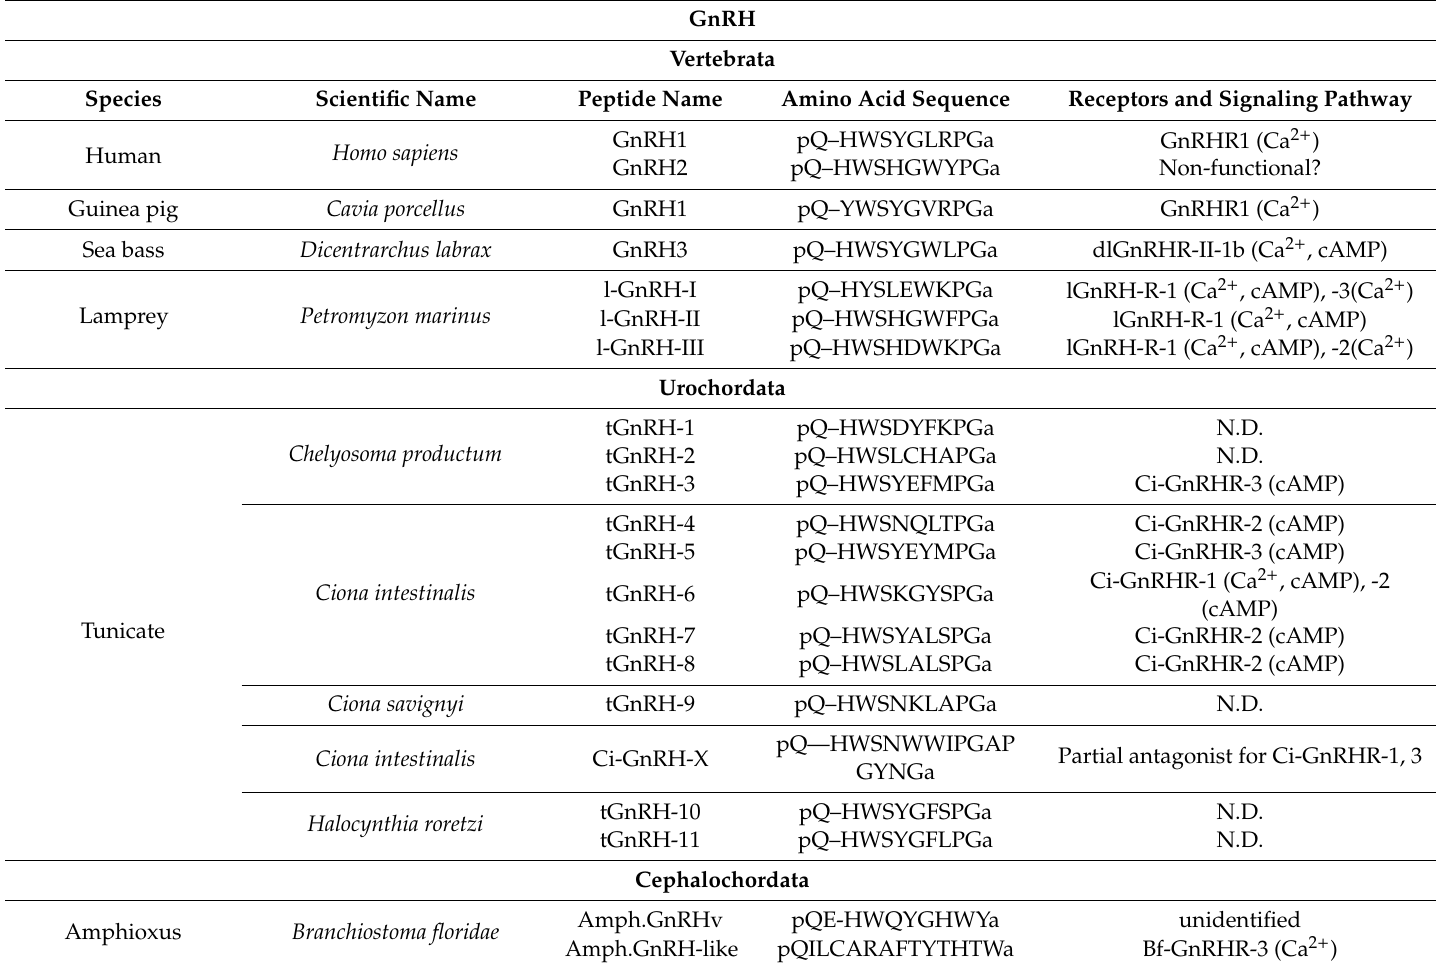
Table 1. Gonadotropin-releasing hormone (GnRH) signaling systems in the animal